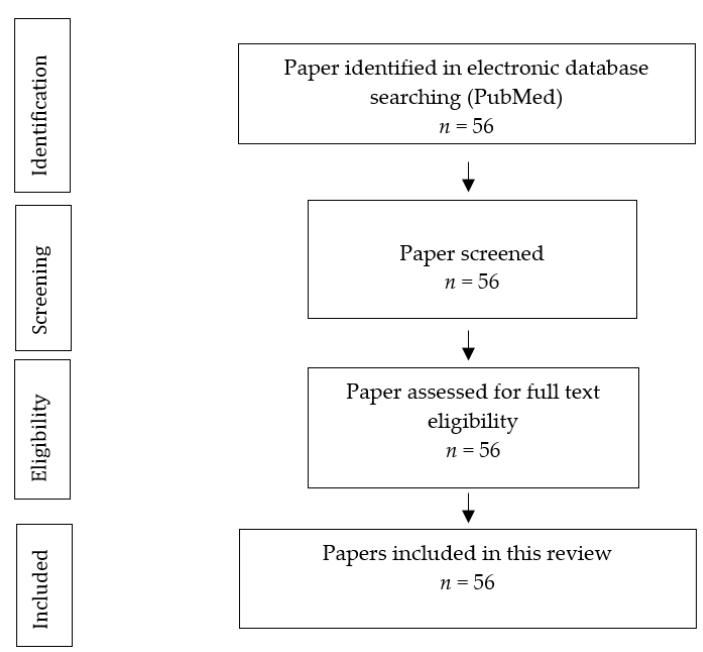
Figure 1. flow chart summarizing study selection method. Figure 1. Flow chart summarizing study selection